Question: Which kind of chart has been used to present this data?
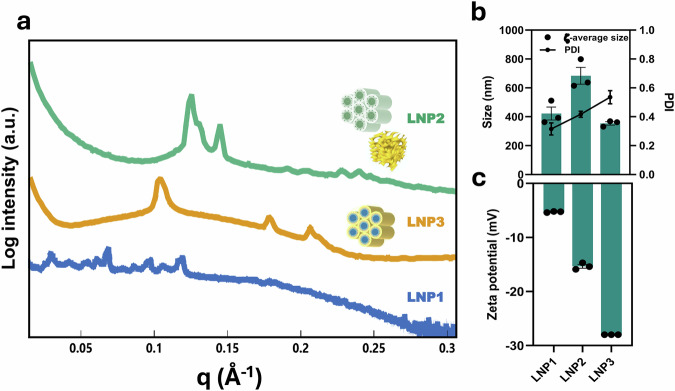
Answer: scatter